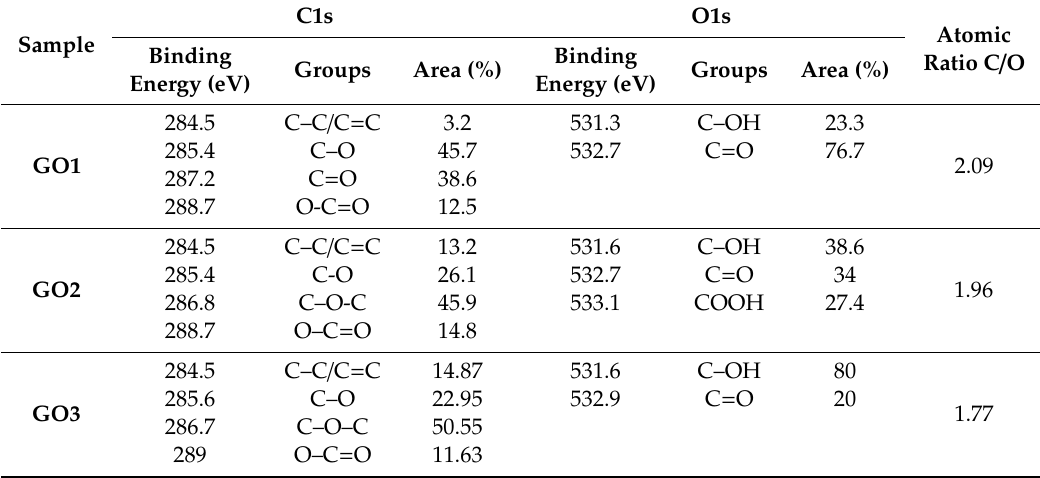
Table 2. X-ray Spectroscopy (XPS) analysis of the C1s and O1s signals of GO1, GO2, and